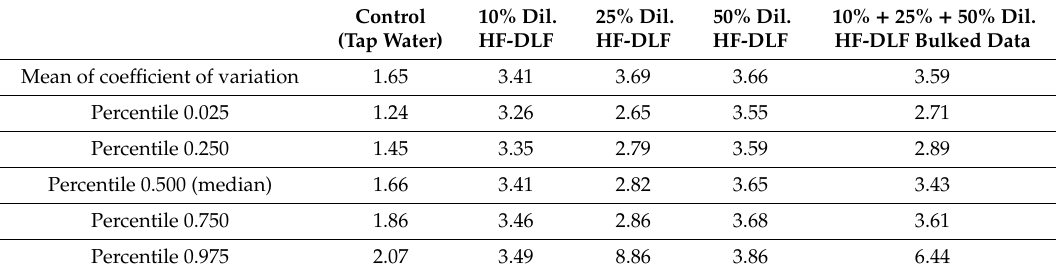
Table 3. Coe ffi cient of variation of each treatment (n = 9, consisting of 3 lines with 3 emitters each) and relative distribution percentiles at 0.025, 0.25, 0.5 (median), 0.75, and 0.975. Data of the three dilutions of the hydrocyclone filtered digestate liquid fraction (HF-DLF) were showed singly and bulked.